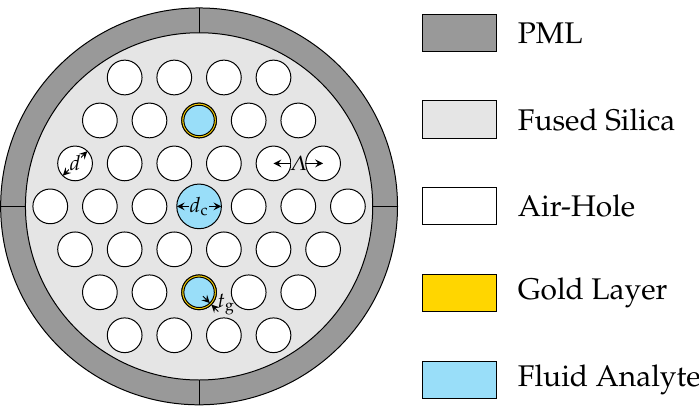
Figure 1. Schematic structure of the cross-section of the HC-PCF-based SPR sensor with Λ = 2µm, d = 1.4µm, t g = 50nm and d c =